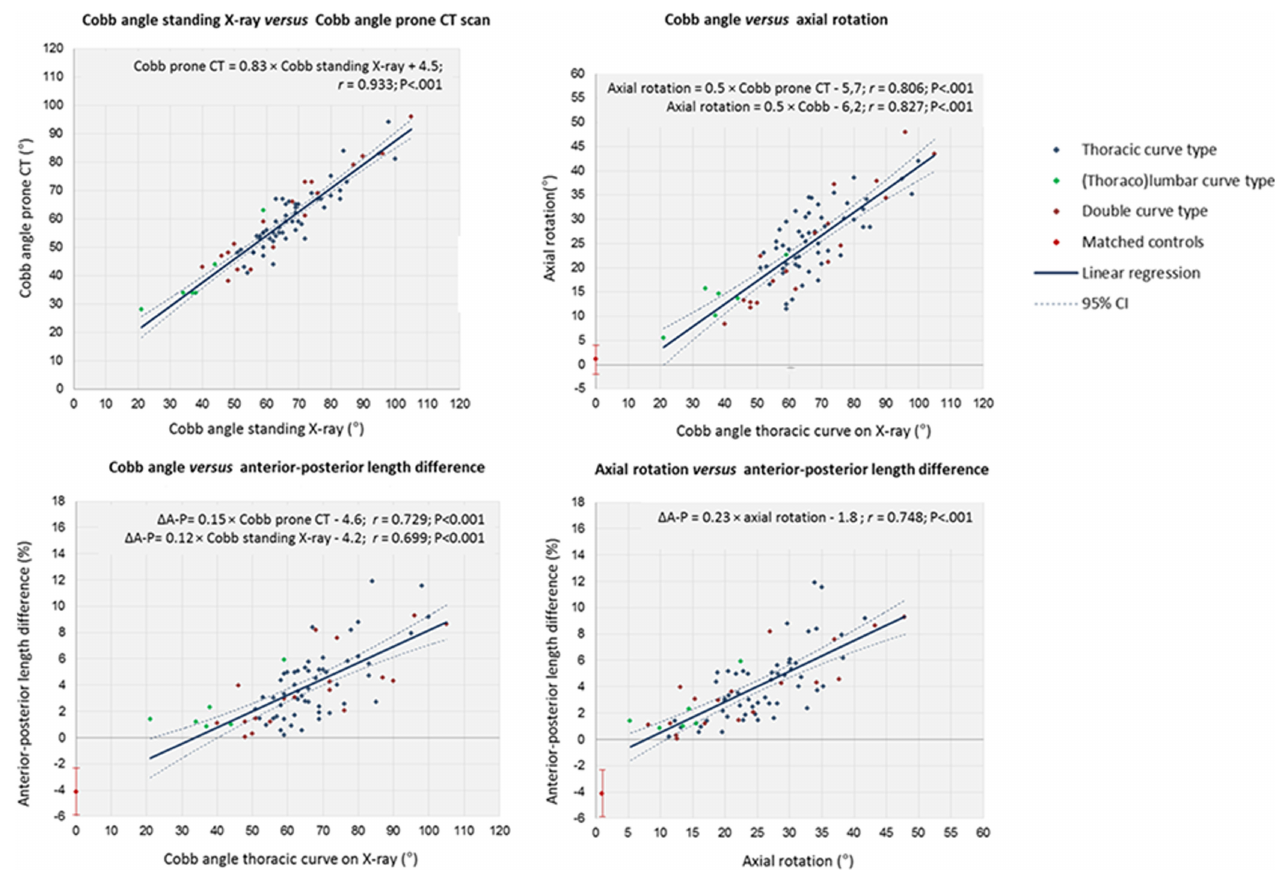
Fig 2. Correlation between Cobb angle of the main thoracic curve on standing radiographs versus prone CT scans, between the deformation in three-dimensions. Pearson ’ s correlation coefficients ( r ), linear regression equations and significance levels are shown including the 95% confidence interval (95% CI). For the control group, mean and standard deviations (error bars) are